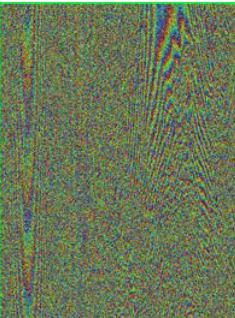
Figure 3. Raw interferogram of ENVISAT